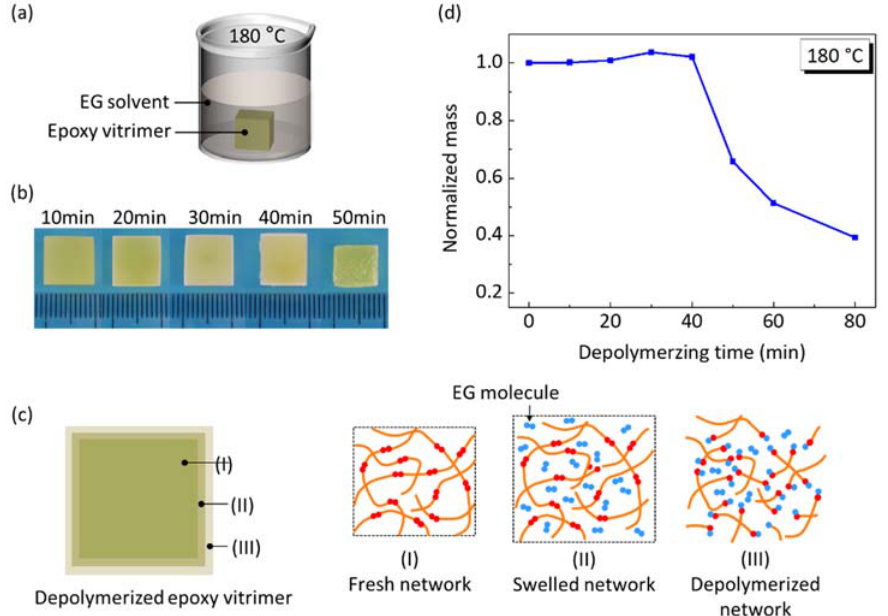
Figure 4. Depolymerization of epoxy vitrimer being immersed into EG at 180 °C. ( a ) Dissolving experiment of the vitrimer. ( b ) The appearance and size evolution of the depolymerized vitrimer. ( c ) Schematic representation of the depolymerized vitrimer. ( d ) Normalized mass of depolymerized vitrimer as a function of depolymerizing time.